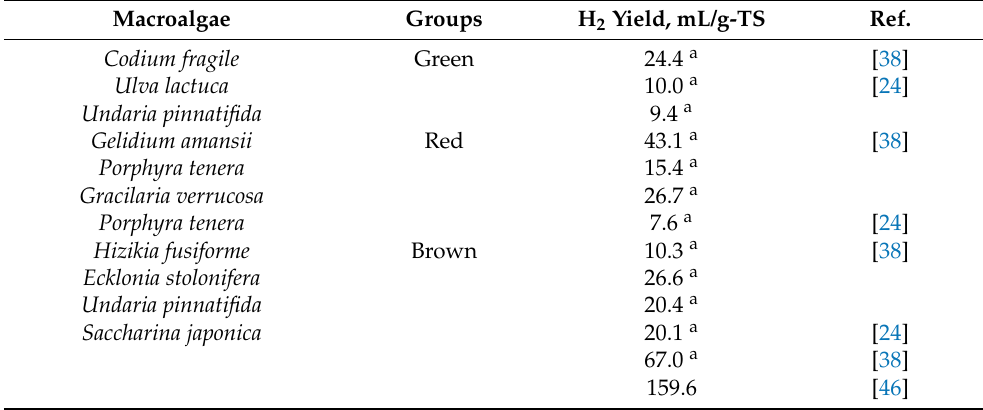
Table 2. Bio-H 2 production from S. japonica compared to some other macroalgae via dark fermentation